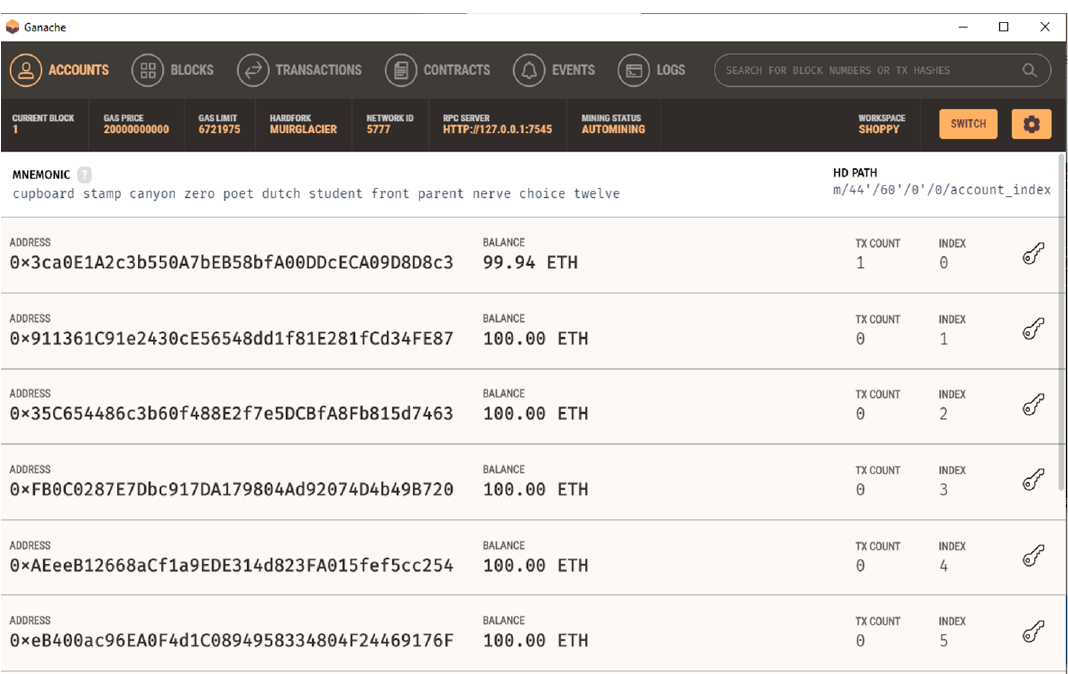
Figure 10. Blockchain implementation tools used.